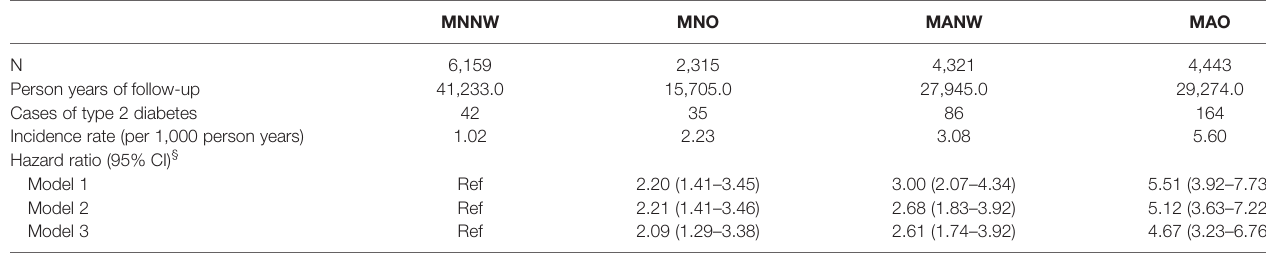
TABLE 2 | Incidences and hazard ratios for type 2 diabetes mellitus in different obese/overweight phenotypes in the Zhejiang cohorts.